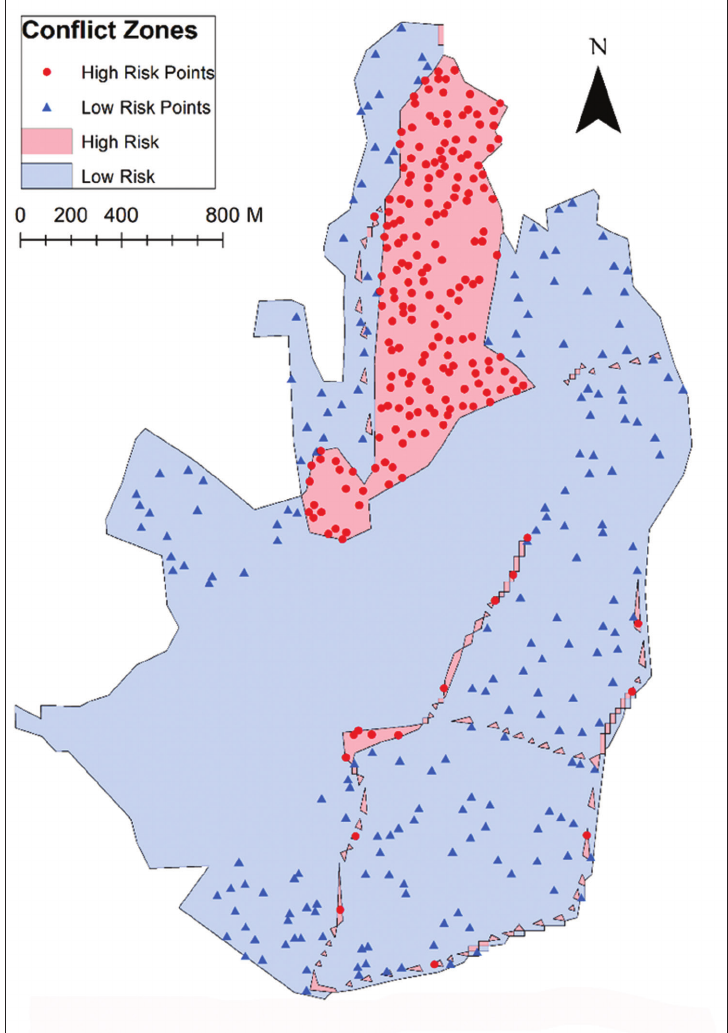
Figure 3. Map showing zones where human-deer ( Cervus elaphus ) encounters have occurred. Locations of randomly sampled points are shown as red dots (high risk points) and blue triangles (low risk points). Data collected from Lyme Park, Disley, UK, in